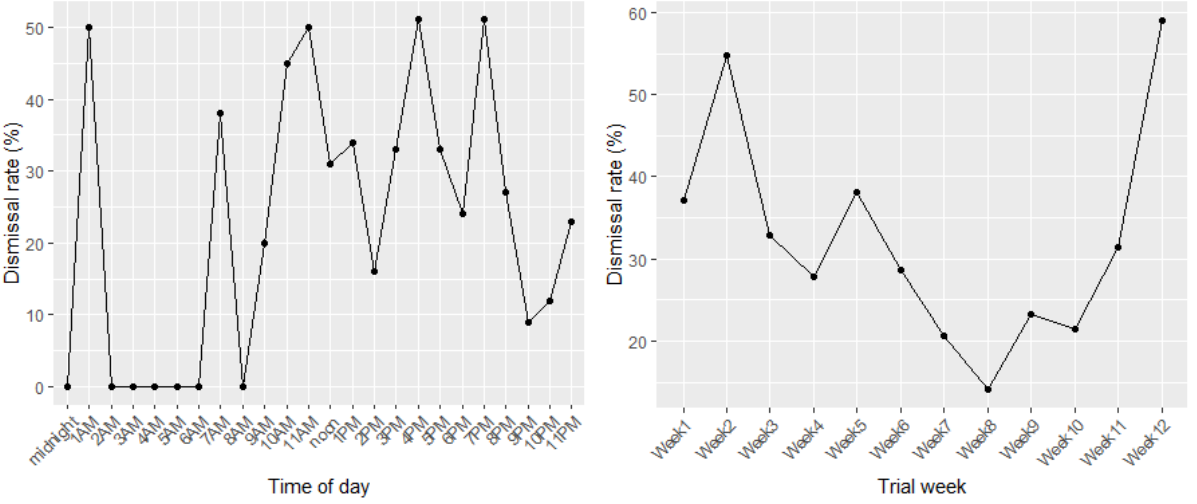
Figure 3. Dismissal rate for ecological momentary assessment questions across hours of day (left) and trial weeks